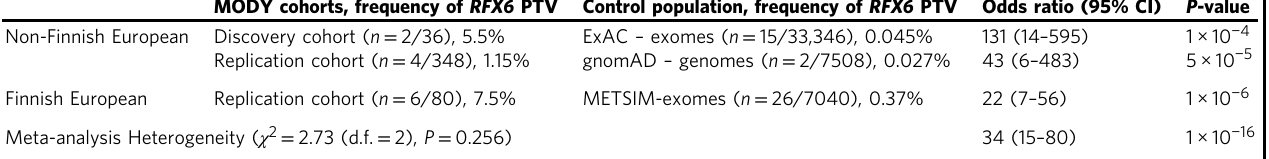
Table 1 Frequency of heterozygous RFX6 protein-truncating variants in all study cohorts and control populations MODY cohorts, frequency of RFX6 PTV Control population, frequency of RFX6 PTV Odds ratio (95% CI) P -value Non-Finnish European Discovery cohort ( n = 2/36),